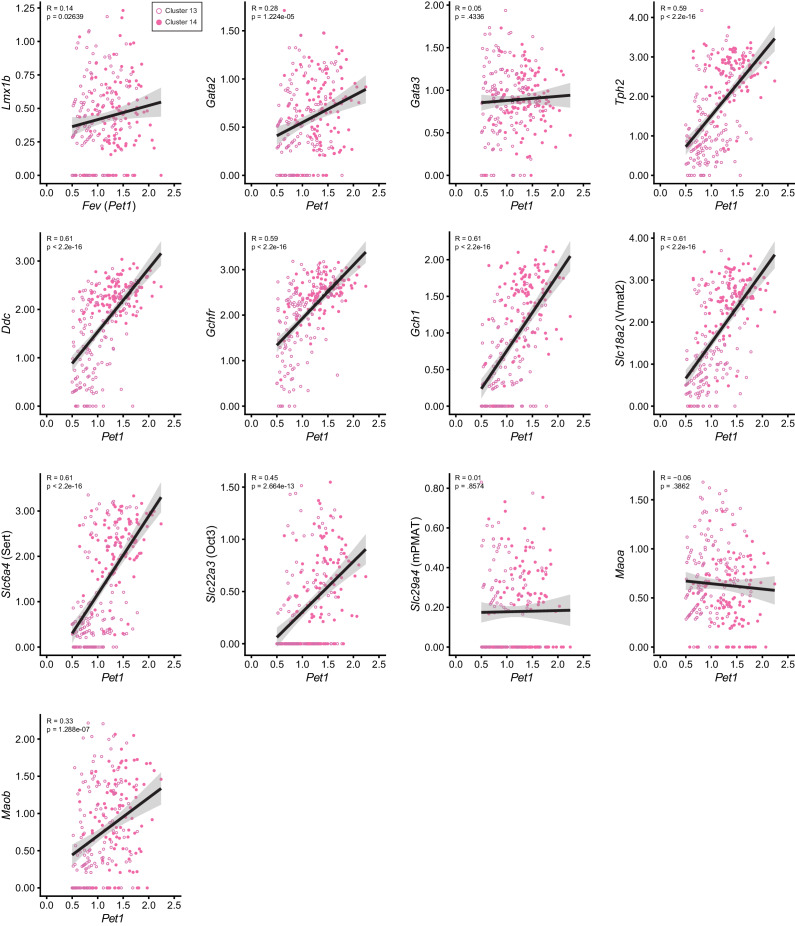
Correlation of 5-HT marker gene expression levels with Fev (Pet1) gene expression levels for clusters 13 and 14.Scatter plots showing the correlation between the normalized expression level of Pet1 (X-axis) and other 5-HT marker genes (Y-axis) for clusters thirteen (light pink open circles) and fourteen (dark pink closed circles). Linear line of best fit for each plot shown in black with corresponding 95% confidence interval in grey. Pearson correlation coefficient and p value displayed in the top left corner of each graph.